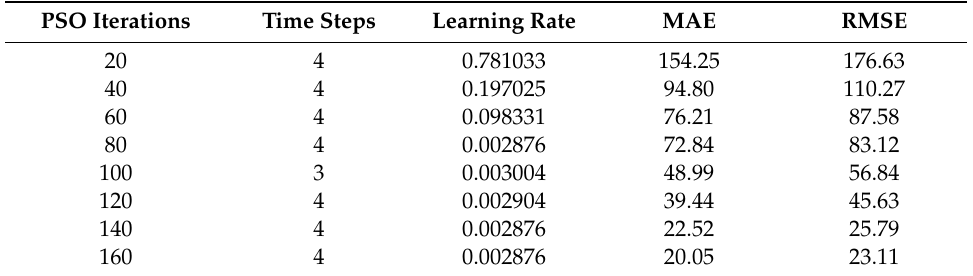
Table 4. Iterative results of using PSO to predict chemical oxygen demand (COD).